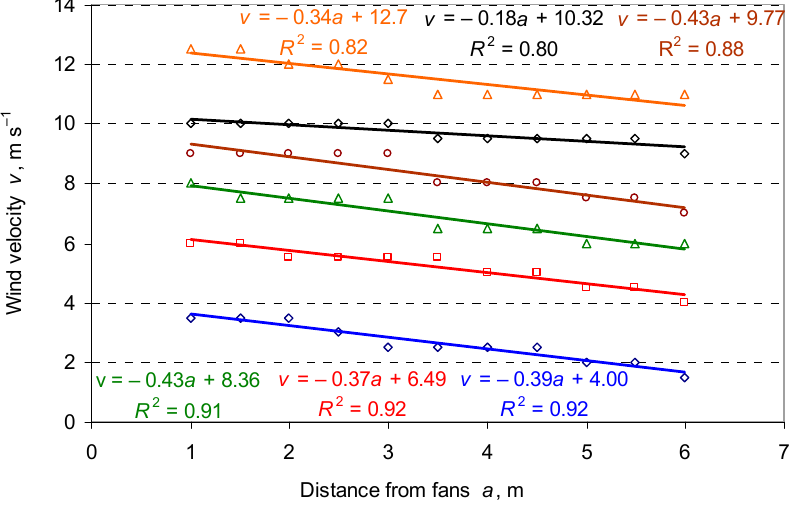
Figure 5. Variation of air velocity with distance from the fans. For the description of droplet distribution, the numerical values of Dv 10 , Dv 90 , and Dv 50 (or volume median diameter VMD ) were determined using DepositScan software. A dimensionless parameter, i.e., relative span ( RS ) was also calculated. RS was used to measure the spread of the droplet sizes in the spray and quantifies the uniformity of the droplet size distribution. The particle RS was calculated through the following equation: RS = ( Dv 90 − Dv 10 )/ Dv 50